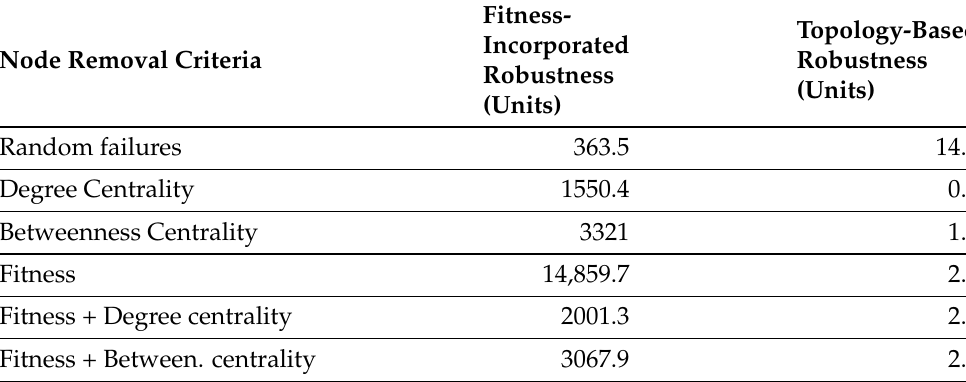
Table 3. Robustness analysis of the scale-free network topology with 100 nodes and 130 links, under different